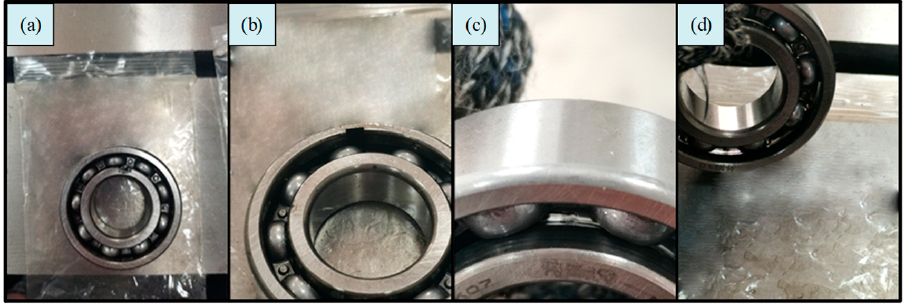
Figure 7. Four types of bearing fault designed in the experiment: ( a ) IRC; ( b ) ORC; ( c ) IRP; ( d ) ORP.